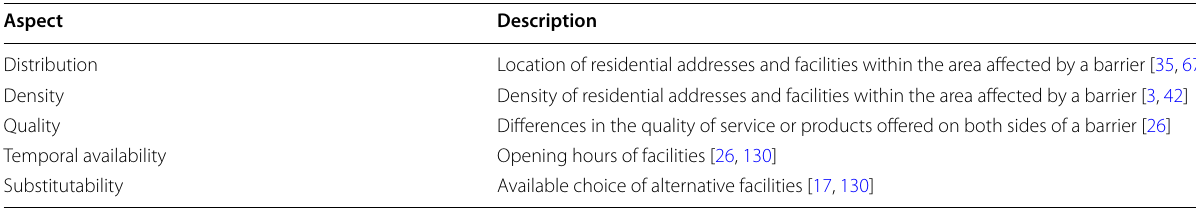
Table 4 Aspects of land use that contribute to barrier